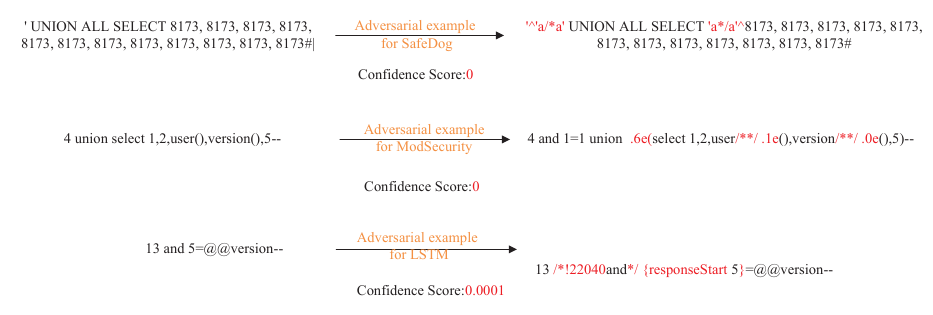
Figure 9. Examples of an adversarial attack